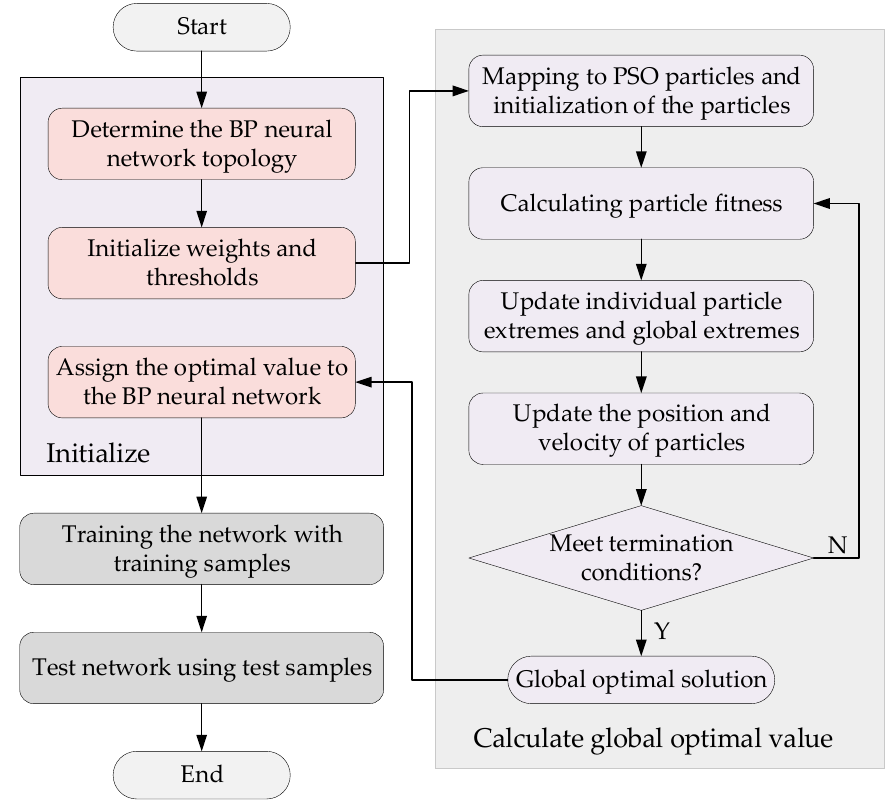
Figure 5. PSO-BO algorithm flow.